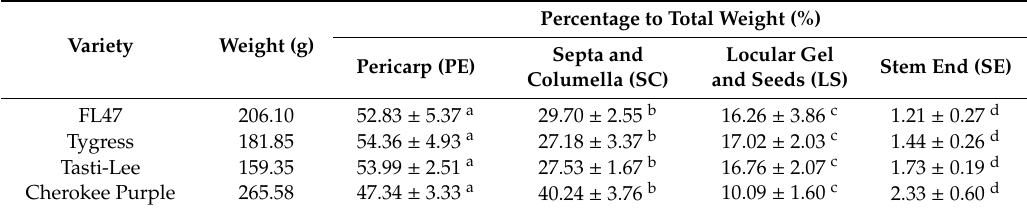
Table 1. Percentage to total weight per tissue in four tomato